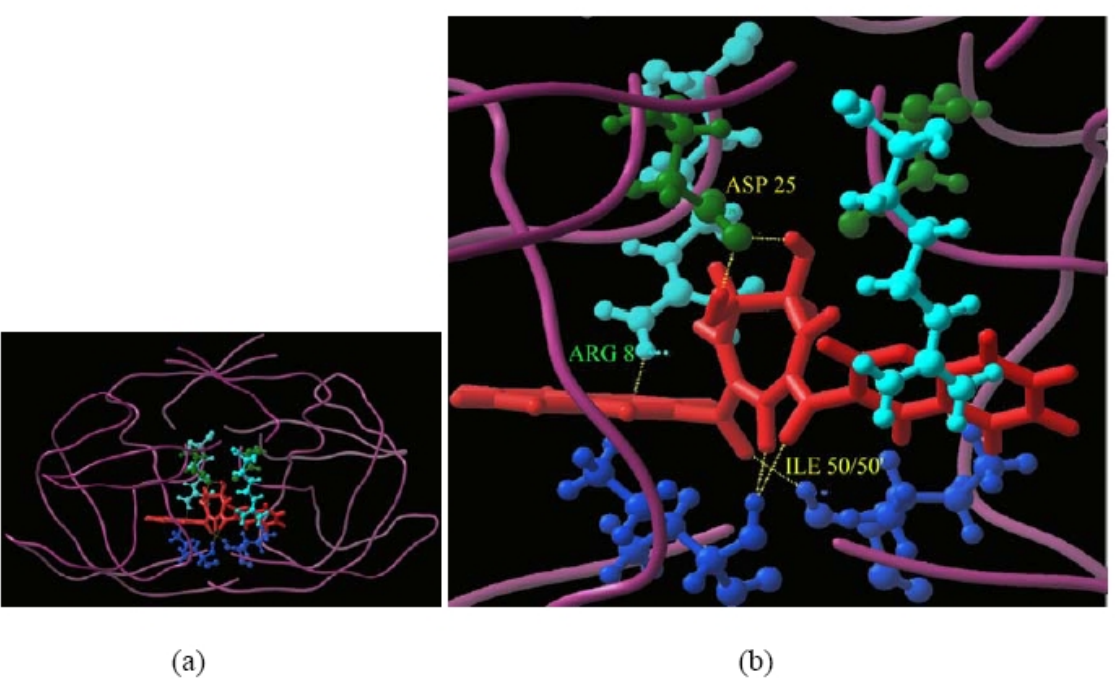
Fig. 4 (a) Inhibitor trione-4 docked into HIV-1 protease (pdb id: 1pro), (b) showing hydrogen bond interaction with active site amino acid residues ASP 25, ILE 50/50’ and ARG